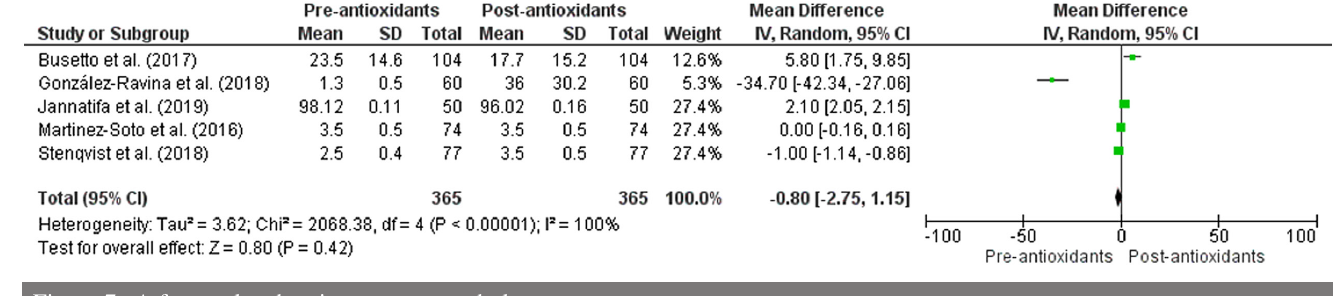
Figure 7. A forest plot showing sperm